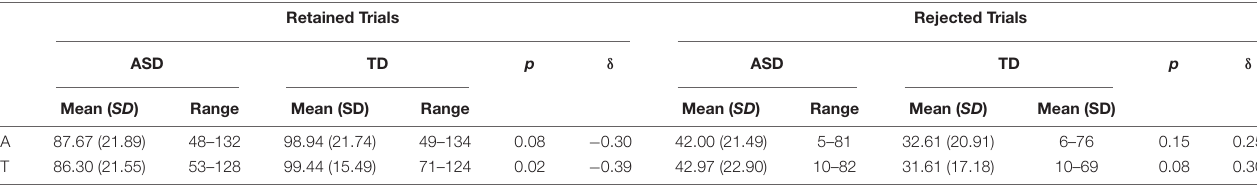
TABLE 2 | Total counts of retained and rejected trials in ERPs by diagnostic group and modality condition (A, auditory, S, somatosensory). Retained Trials Rejected